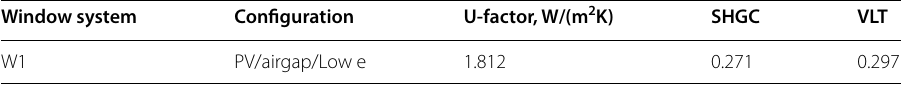
Table 4 Window parameters Window system